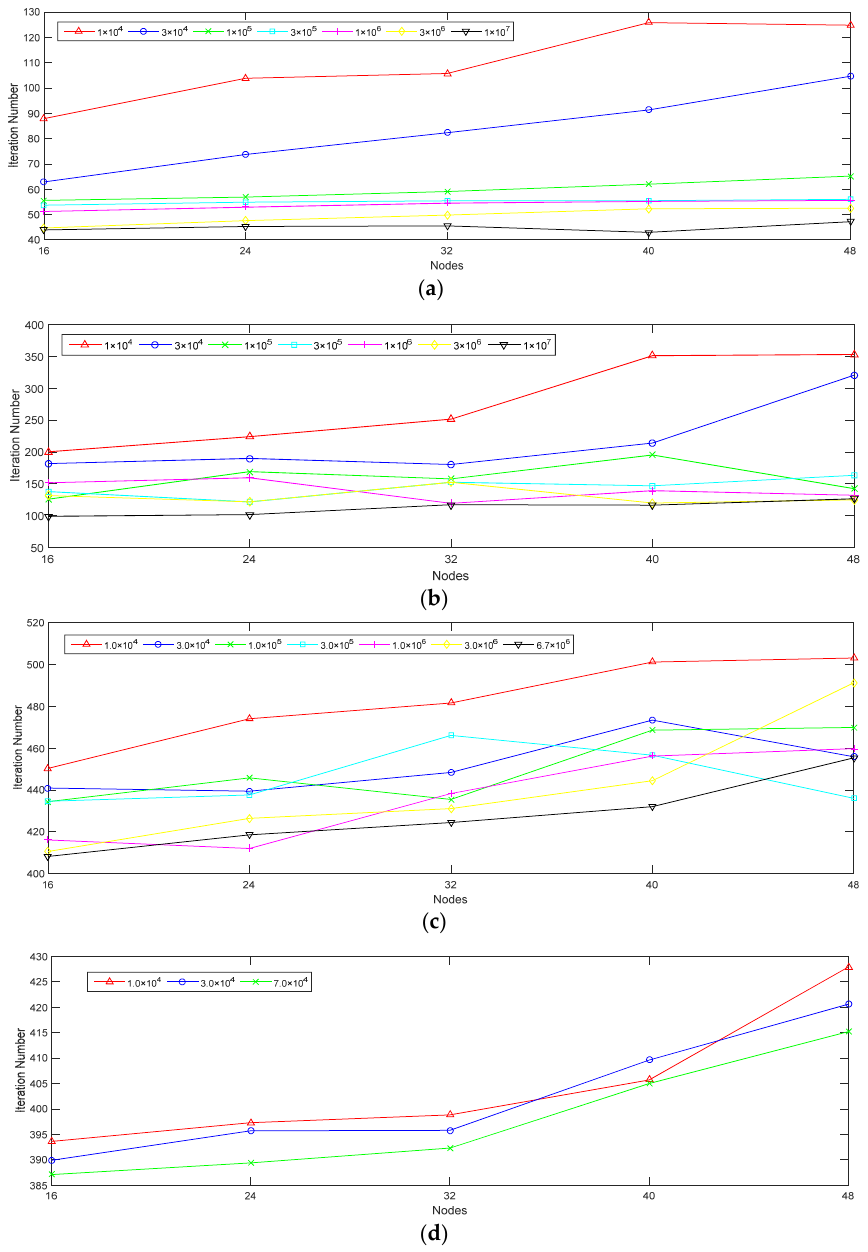
Figure 11. Number of iterations of each dataset in different lengths and nodes. ( a ) Number of iterations of dataset 1; ( b ) Number of iterations of dataset 2; ( c ) Number of iterations of dataset 3; ( d ) Number of iterations of dataset 4.